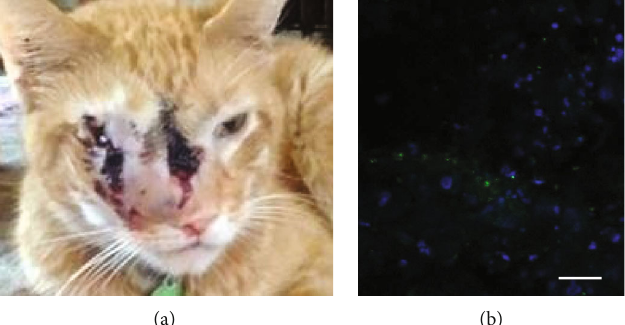
Figure 5: The photograph in (a) depicts the appearance of the mass presented Figure 1 after 2 rounds of treatment with TOL. Note the reduction in localized edema revealing more of the globe of the eye. The photomicrograph in (b), compared to the photomicrograph in Figure 1(b), depicts the relative absence of cells that highly express VGSCs (green) following treatment with TOL. The calibration bar = 25 μ m .